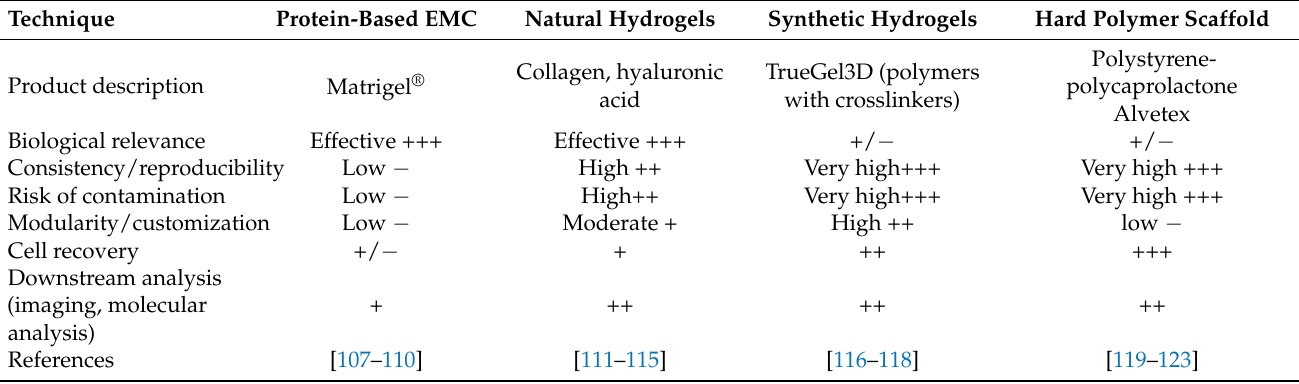
Table 2. Scaffold-based 3D techniques overview with